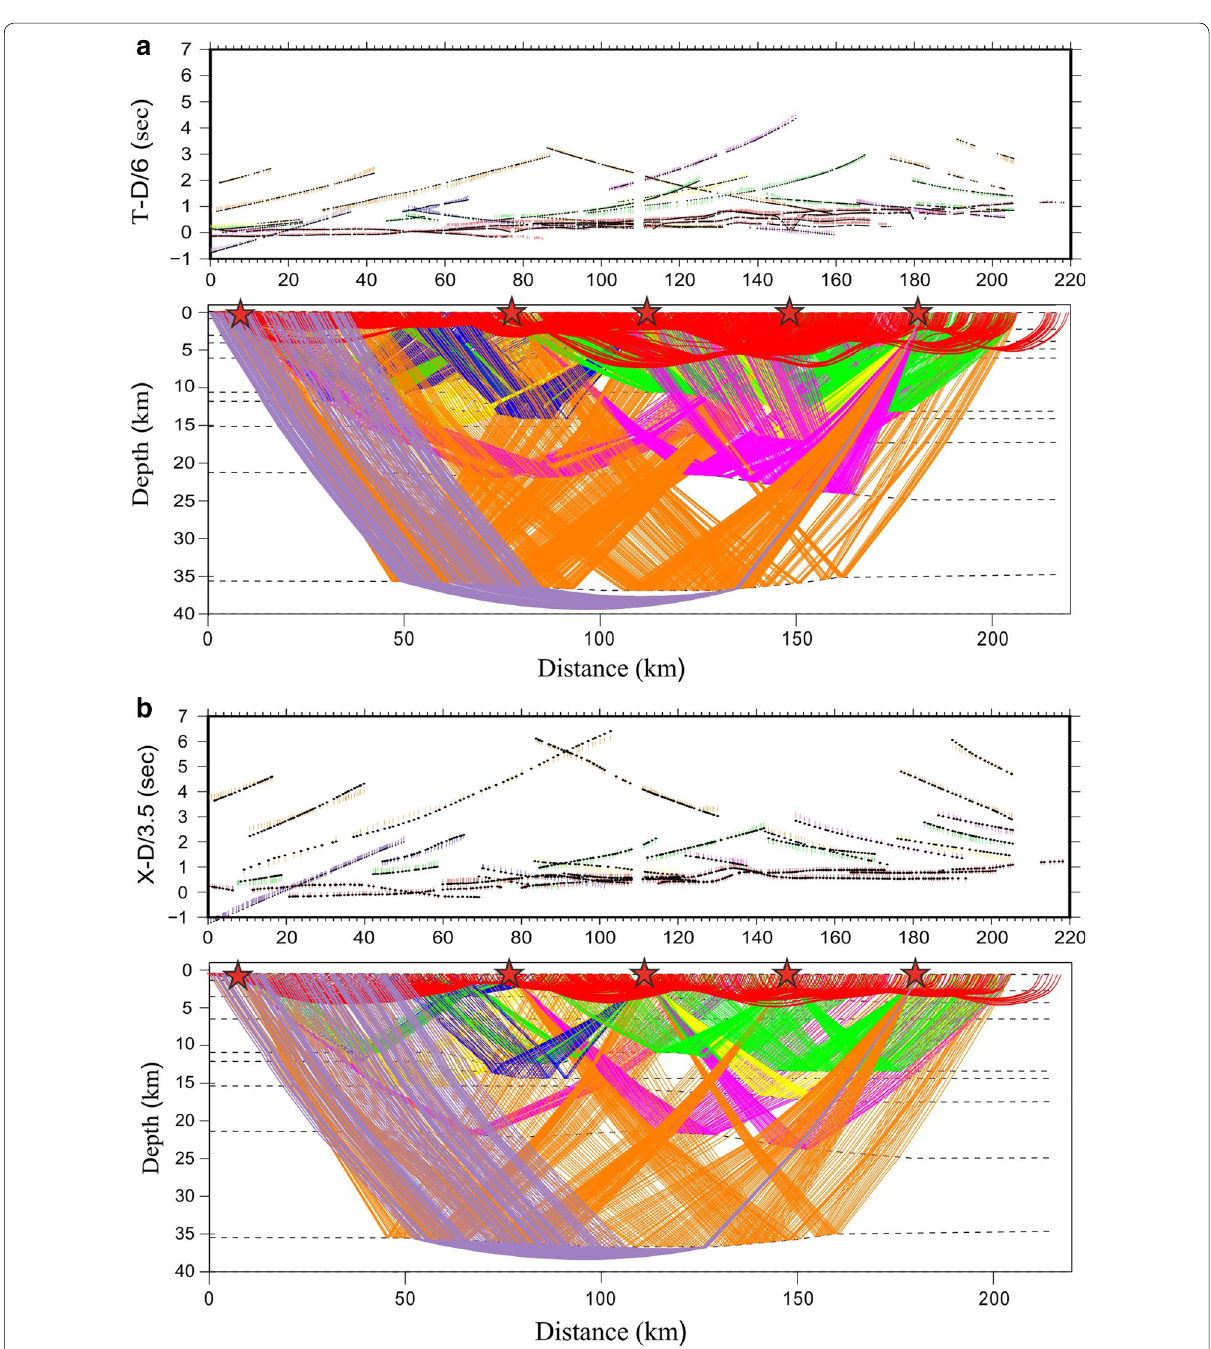
Fig. 9 a The P-wave traveltime fit and seismic ray diagram. b The S-wave traveltime fit and seismic ray diagram. The rays emanate from each of the five shot points and are color coded by the crustal boundary from which they either refract or reflect. The density of ray coverage gives a qualitative indication of which portions of the model are well constrained. The short color segment is the observed times of the rays which have the same color in the seismic ray diagram. The length of segments indicates the estimated picking error. The black nodes are the calculated